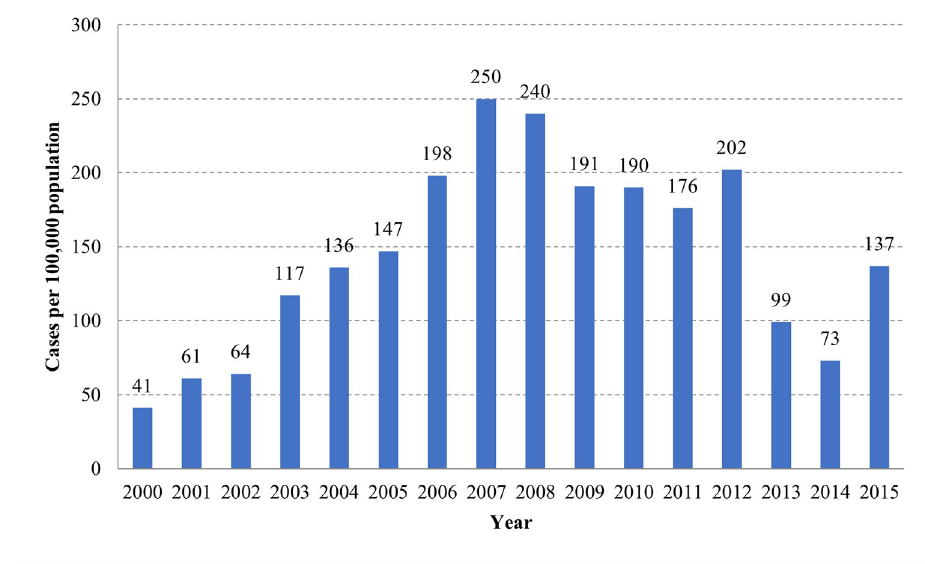
Fig 2. Incidence of clinical dengue cases per 100,000